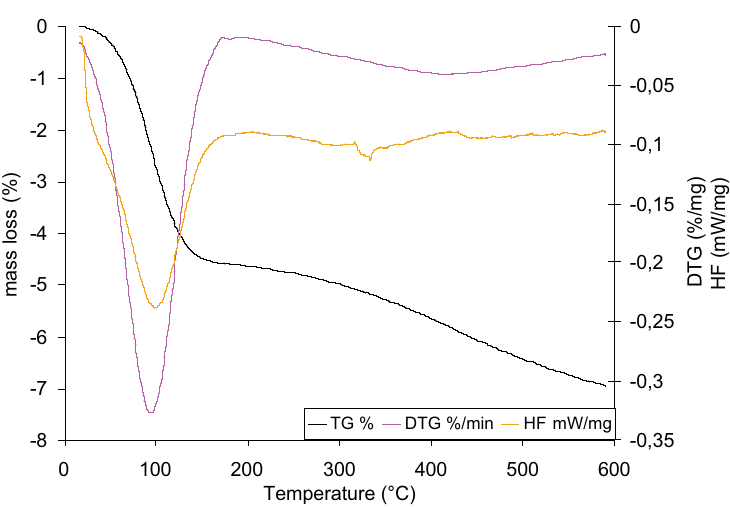
Fig. 3 TG-DSC diagrams for silica gel.